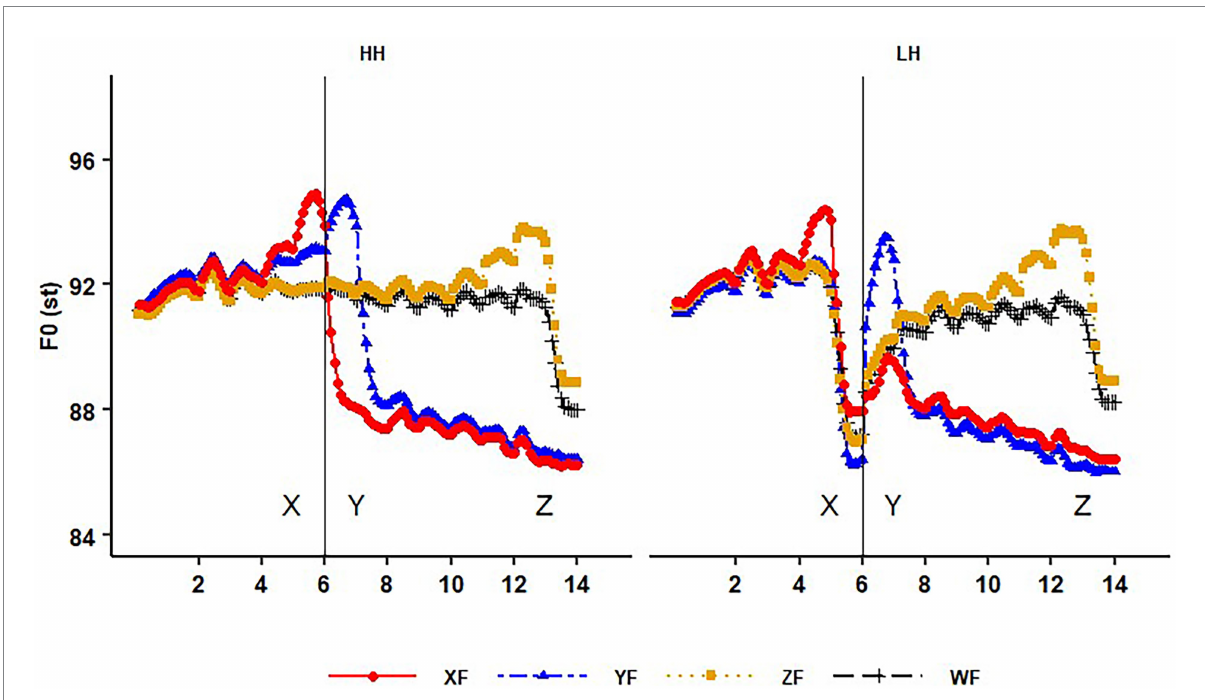
FIGURE 2 Time-normalized intonation contours of the HH (left) and LH (right) sentences in the conditions of the syllable boundary (between syllable X and Y), with the four focus conditions overlaid in one figure. Here XF, YF, ZF and WF stand for focus in word X, Y, Z and the wide focus condition. The x -axis are the syllable numbers. The vertical line indicates the critical boundary between X and